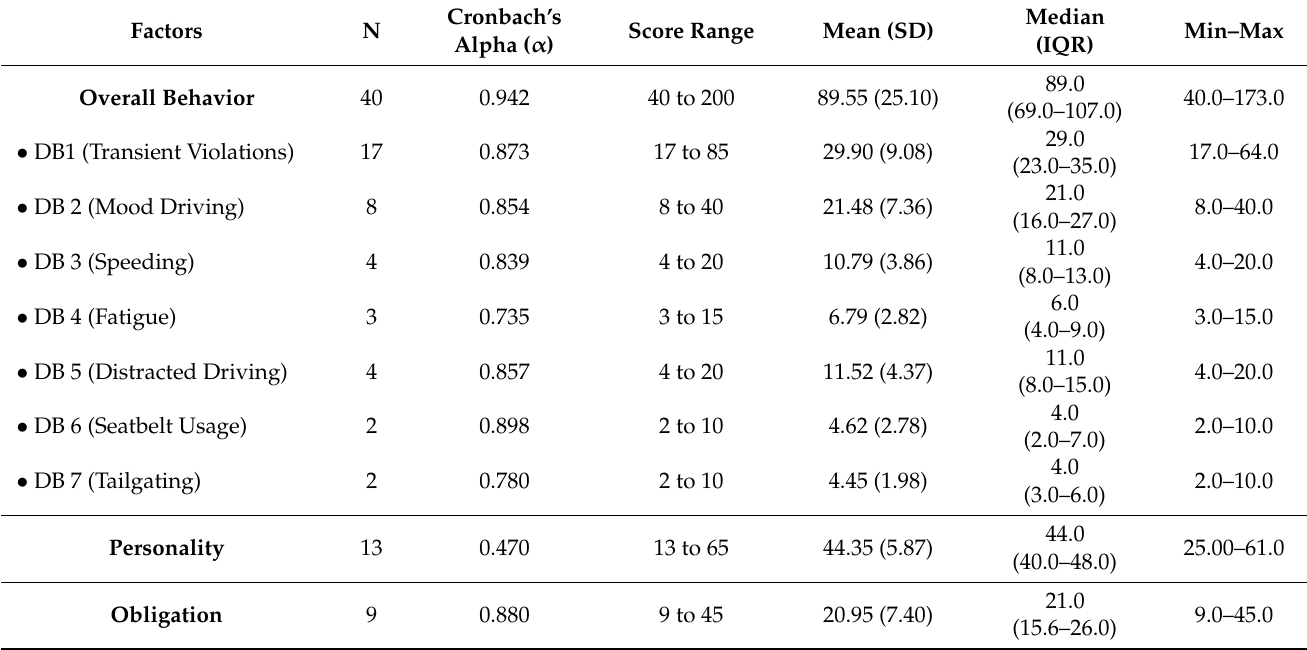
Table 4. Reliability measures of survey tool.